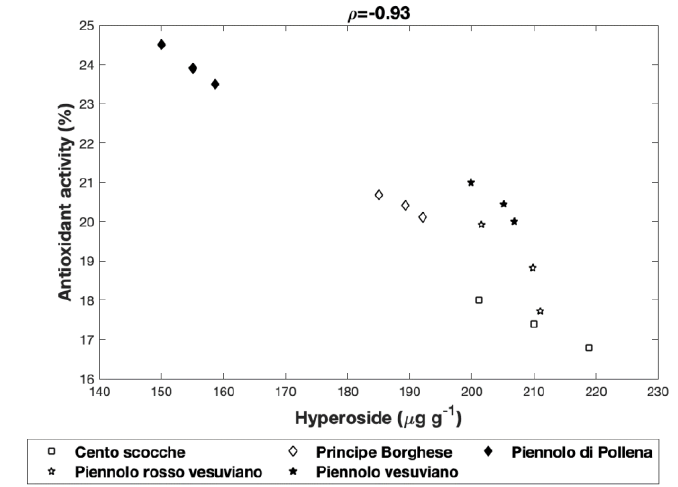
Figure 1. Interrelationships among the antioxidant activity exhibited by the three samples for each landrace of “Piennolo” tomato and the antioxidant activity and the content of hyperoside.